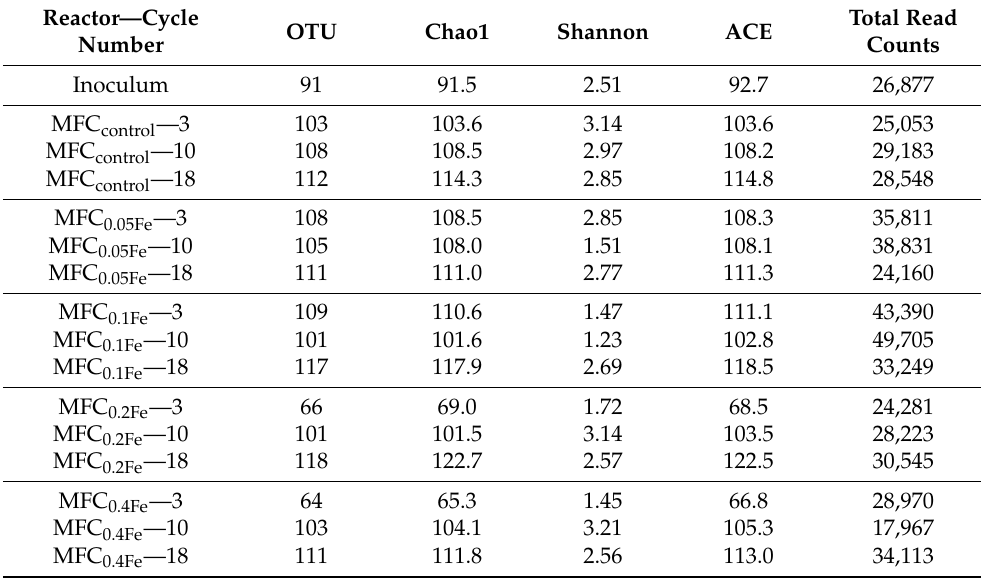
Table 1. Alpha diversity indicators in all MFC reactors; the number after the reactor name indicates the cycle in which sampling was performed; OUT—operational taxonomic unit, Chao1—richness estimator, Shannon—biodiversity index, ACE—abundance-based coverage